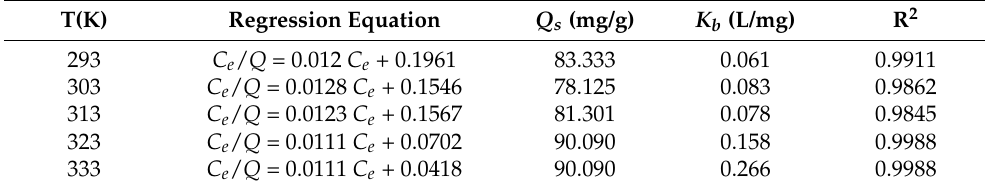
Table 4. Langmuir constants of methyl orange adsorption onto MRCM.